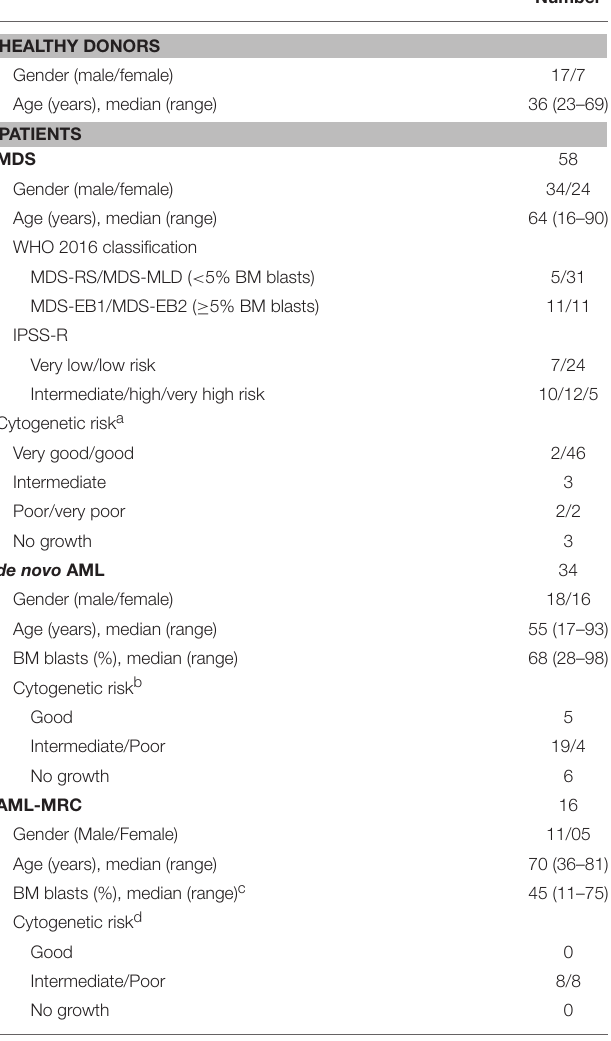
(GE, Uppsala, Sweden) from diagnostic samples of AML patients and cord blood units (CBU) samples from